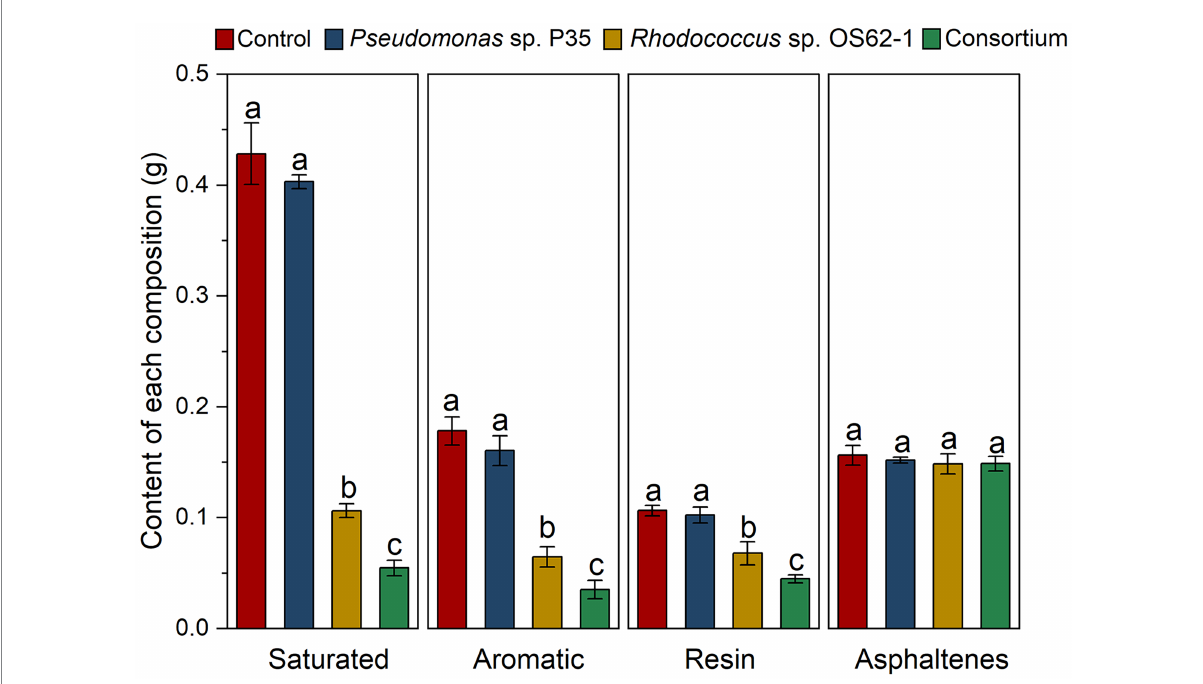
FIGURE 6 Changes of contents of different components in crude oil under different treatments in 7 days. Groups sharing different letters (a, b, c) indicate significant differences between two treatments by one-way ANOVA test ( p <